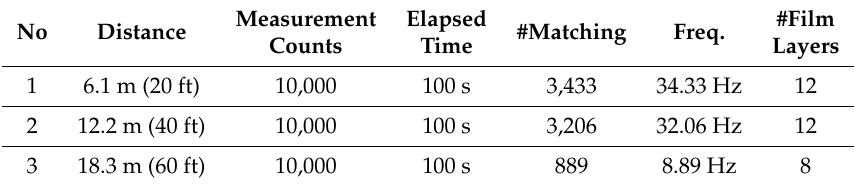
Figure 8. The Test Site, the IR source, and the Sunlight Reflector. ( a ) Test Site (side view); ( b ) Test Site (front view); ( c ) IR Beacon and Sunlight Reflector. Table 2. Outdoor data statistics with the variation of the distance of the IR